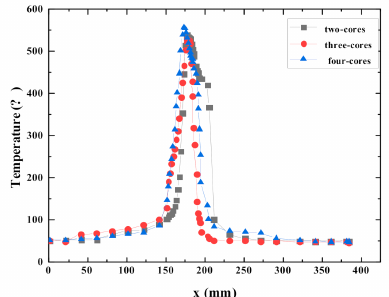
Figure 13. Surface temperature distribution in the core area of a single cable during flame